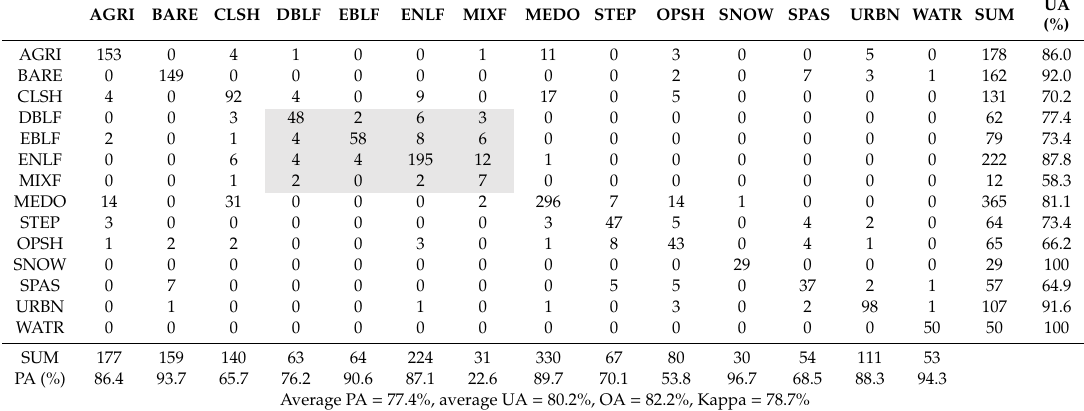
Table 1. Confusion matrix of the classification (UA, user’s accuracy; PA, producer’s accuracy; OA, overall accuracy; Kappa, Kappa statistics; AGRI, agricultural land; BARE, bare ground; CLSH, closed shrubland; DBLF, deciduous broadleaved forest; EBLF, evergreen broadleaved forest; ENLF, evergreen needle-leaved forest; MIXF, mixed forest; MEDO, meadow; OPSH, open shrubland; SNOW, permanent snow cover; STEP, steppe; SPAS, sparse vegetation; URBN, urban area; and WATR,